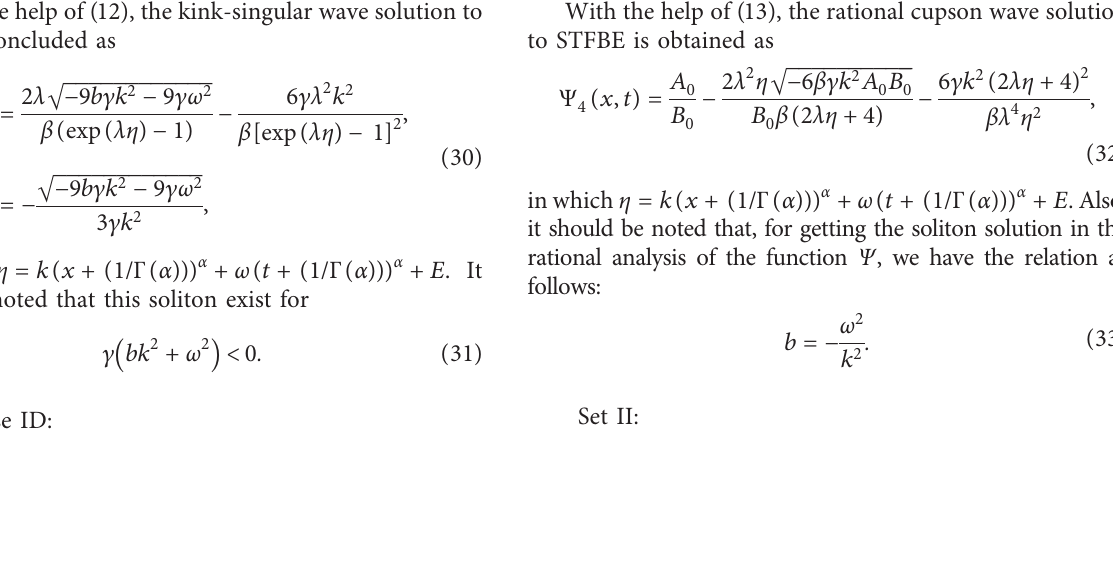
Figure 2: The plot of (28) Ψ plot (red α � 0 . 5, blue α � 0 . 75, and green α � 0 .